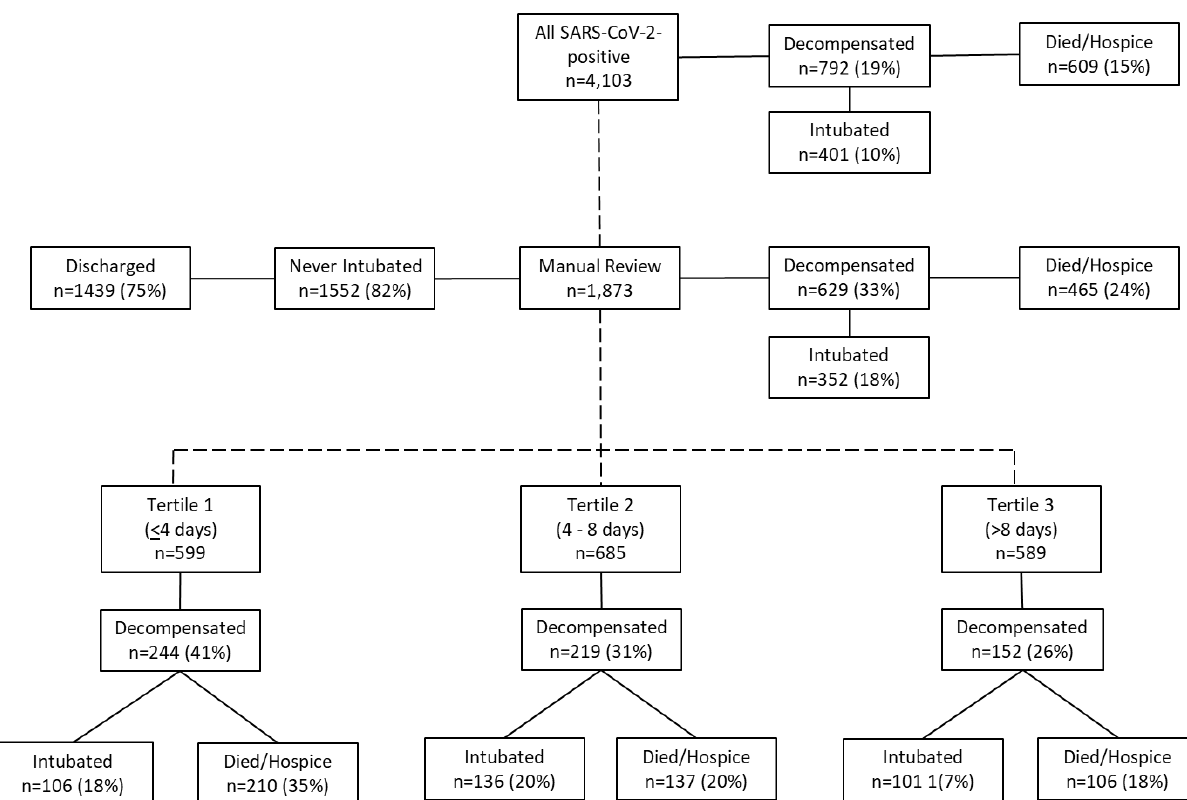
Figure 1. Flow chart of nested case–control study design.